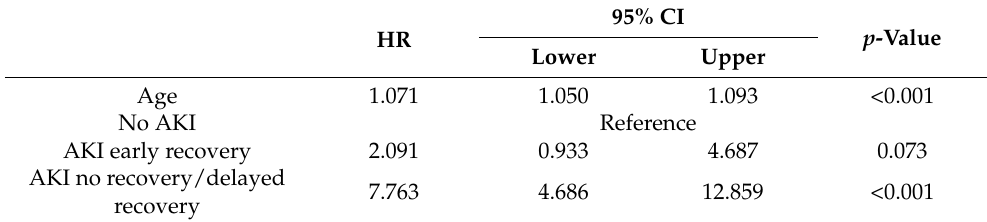
Figure 2. Cumulative survival rates for 2943 patients with STEMI based on AKI resolution. Abbreviations: AKI, acute kidney injury. * p -value > 0.05, ** p -value < 0.001. Table 3. Cox regression model for 1-year mortality.